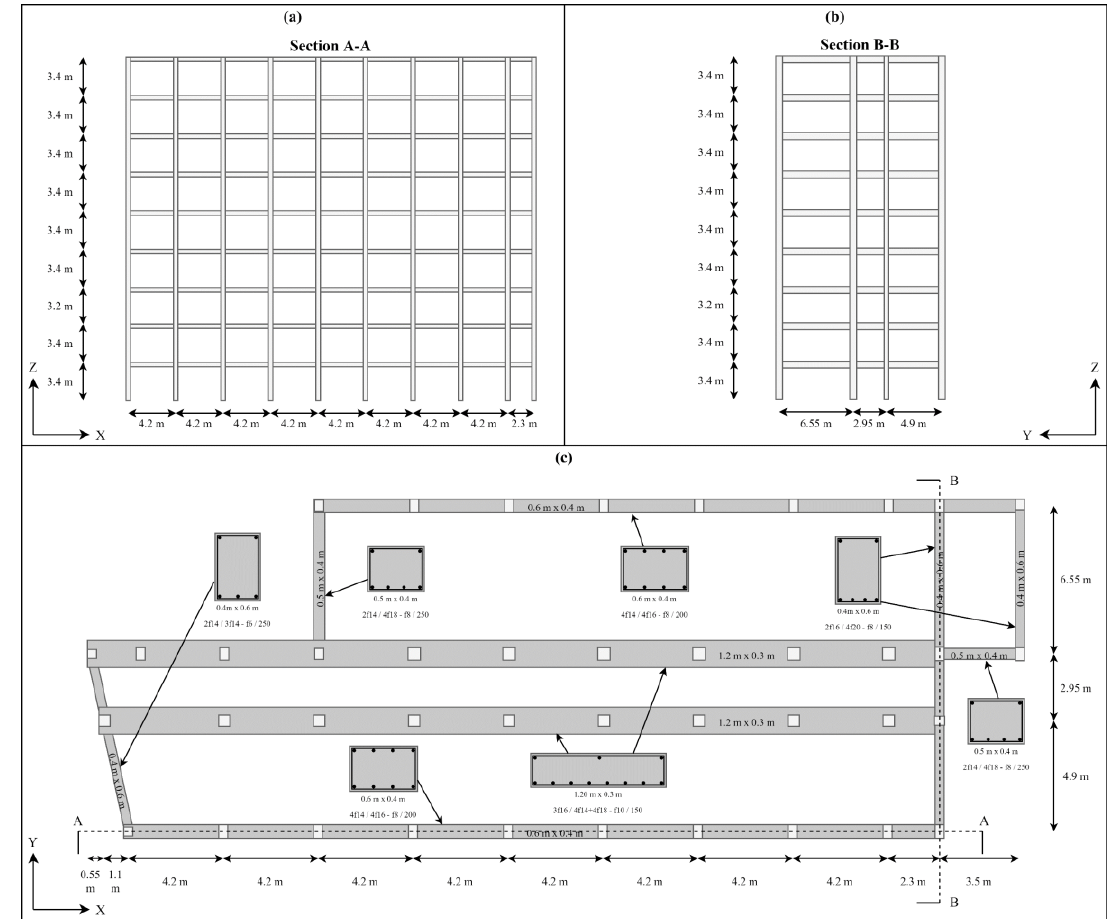
Figure 1. Illustration of the main hospital building geometrical configuration; ( a ) front view in XZ (section A-A), ( b ) side view in YZ (section B-B), and ( c ) plan-view in XY.